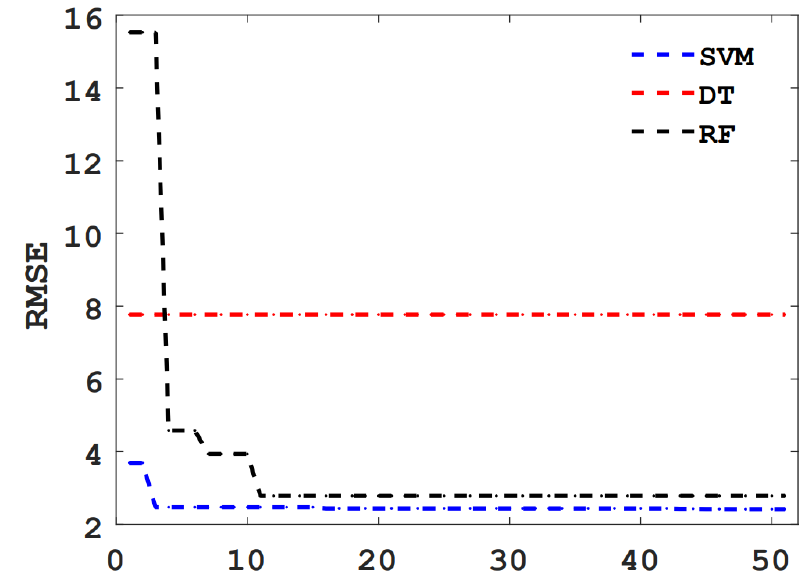
Figure 6. RMSE values for different ML models.